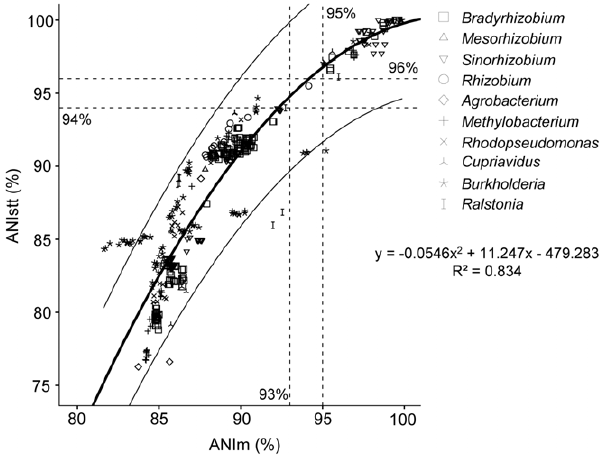
Figure 2. Plotted results of ANIstt (average nucleotide identity of SMc00019-truA-thrA ) versus ANIm (genomic ANI). 460 intra- genus pairwise comparisons in Bradyrhizobium (190), Mesorhizobium (3), Sinorhizobium (91), Rhizobium (10), Agrobacterium (6), Cupriavidus (10), Methylobacterium (28), Ralstonia (10), Rhodopseudomonas (21) and Burkholderia (91). 7/460 points lie between the interspecies region (ANIm , 93% and ANIstt , 94%) and the intraspecies region (ANIm . 95% and ANIstt . 96%). The thick and fine solid line(s) depicted the quadratic curve (the best curve to fit the data) and the individual confidence intervals (95%). The quadratic equation and R square are shown.